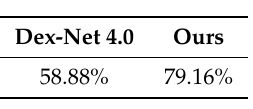
Table 2. Percentage of grasp points with a distance to a surface center of less than 30